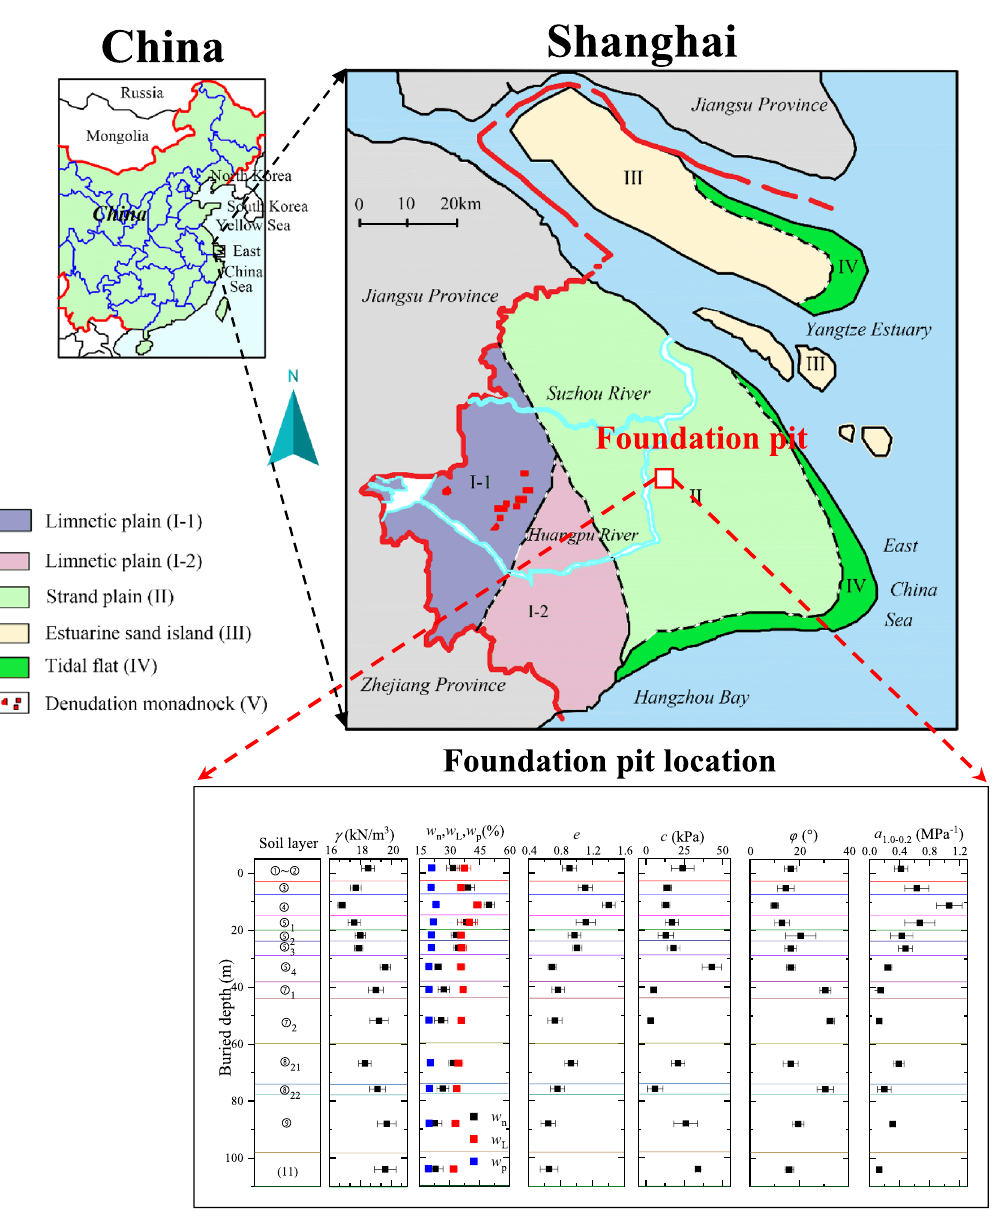
Figure 2. Layout of the No. 4 working shaft